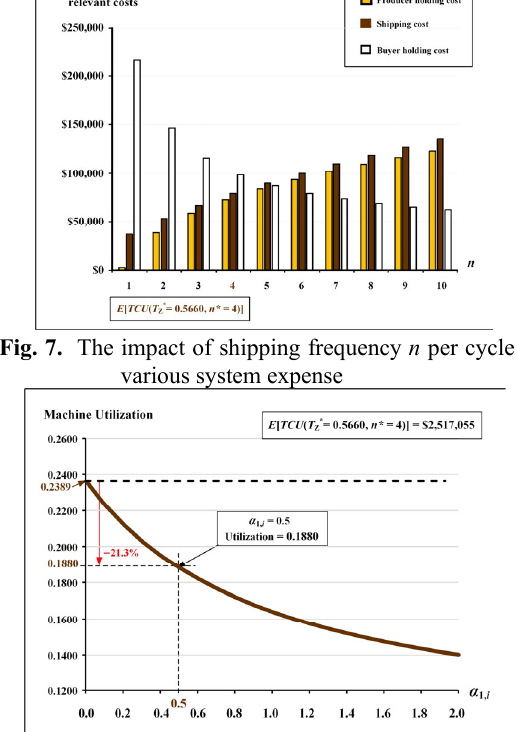
Fig. 8. E [ TCU ( T Z *, n *)]’s performance concerning the mean rework cost over unit cost